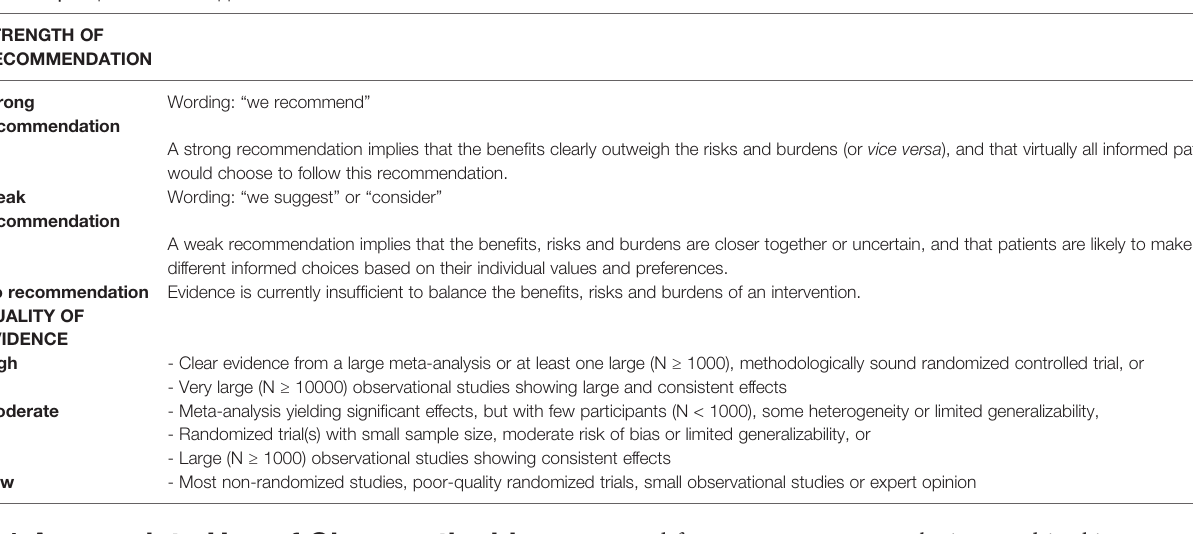
TABLE 1 | Simpli fi ed GRADE